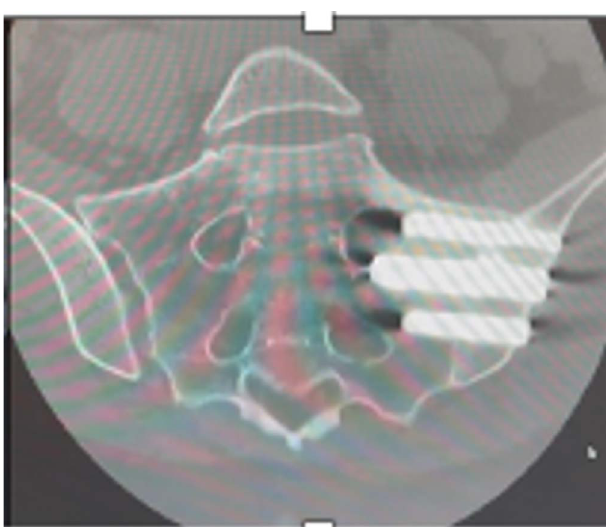
Figure 4. CT scan showing coronal cuts along axis of a dysmorphic sacrum. Note the high angulation of sacral alar and big neural foramina. The implant fi xation was limited to Dennis I zone to allow for safe placement of implant.